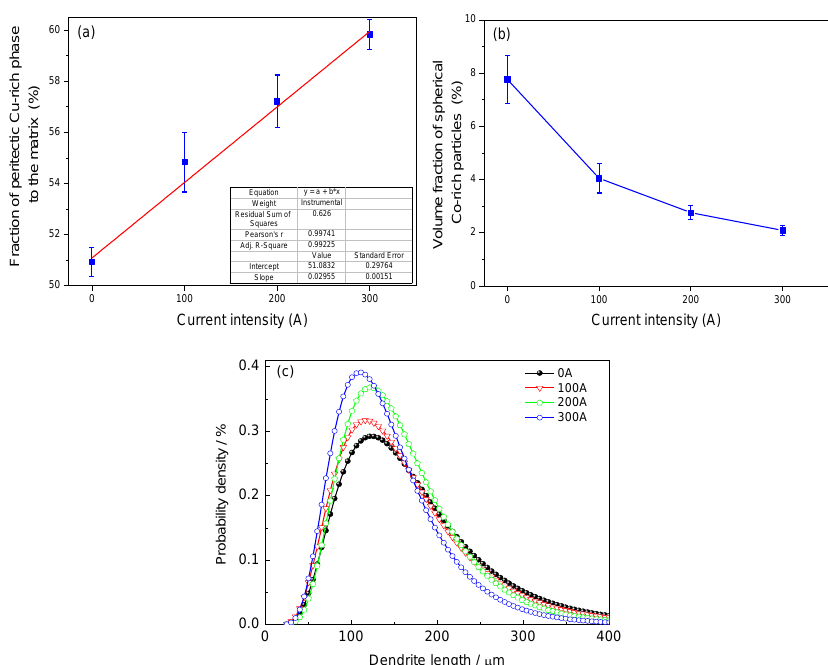
Figure 5. This is the statistic results analyzed from the microstructures: ( a ) The fraction of peritectic Cu-rich phase changed with the current intensity of EMS; ( b ) The fraction of spherical Co-rich particles changed with the current intensity of EMS; ( c ) Probability density of α-Co dendritic length under four different stirring current intensity. The red line is the linear fit line.